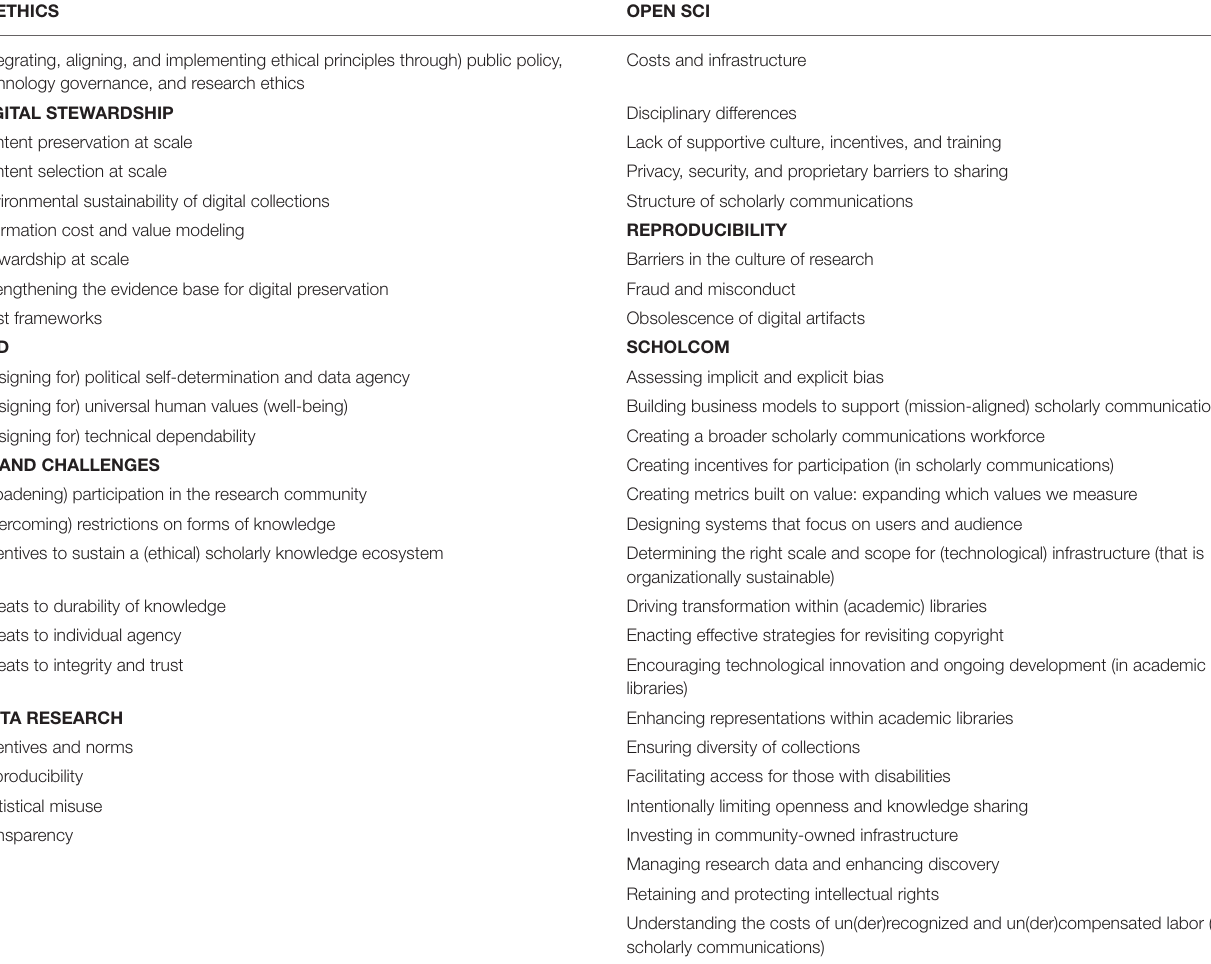
TABLE 4 | Research